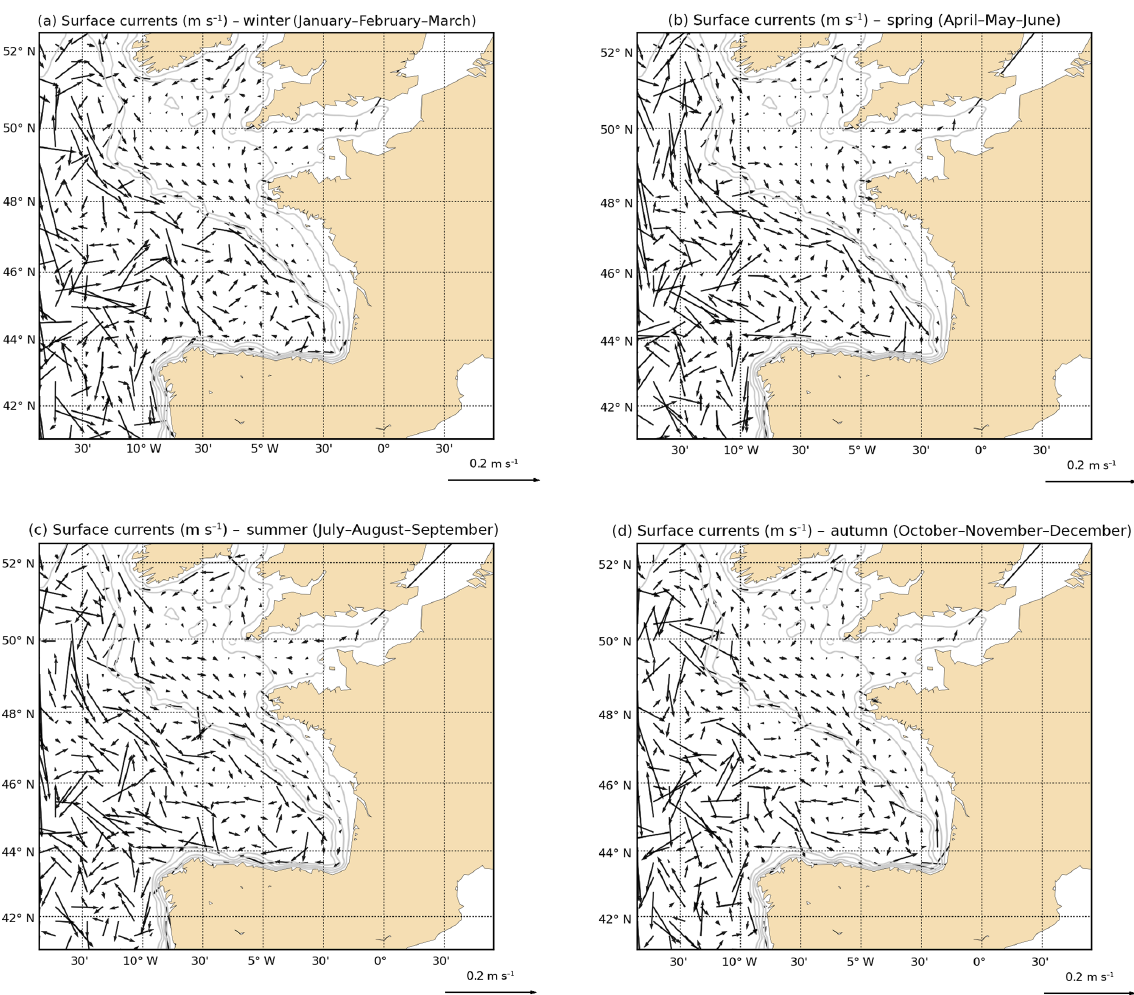
Figure 6. Average modelled seasonal circulation ( a : winter, b : spring, c : summer, d : autumn) for surface layers (0–50m depth) over the period 2001–2010 (for clarity purposes, fields have undersampled and 1 over 50 grid points are plotted). Gray lines represent 500, 200, 100 and 50m